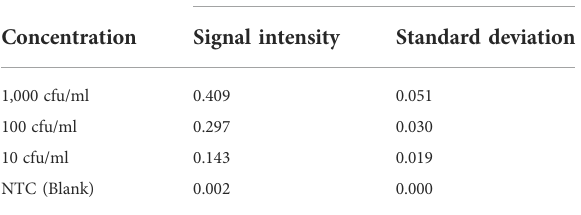
FIGURE 6 Validation of AELA PCR: Signal intensities for Staphylococcus aureus probeobtainedafterampli fi cationwith50asymmetricPCR ampli fi cation cycles and AELA-PCR of extracted Staphylococcus aureus template from spiked blood culture samples and hybridizing the amplicons. The error bars represent standard deviation across three replicates ( n = 3) for each dataset and CFU/ ml represents Colony Forming Units per ml of blood. The “ p -values ” shows the signi fi cance for t -test for null hypothesis, which means any value ≤ 0.05 is signi fi cant.